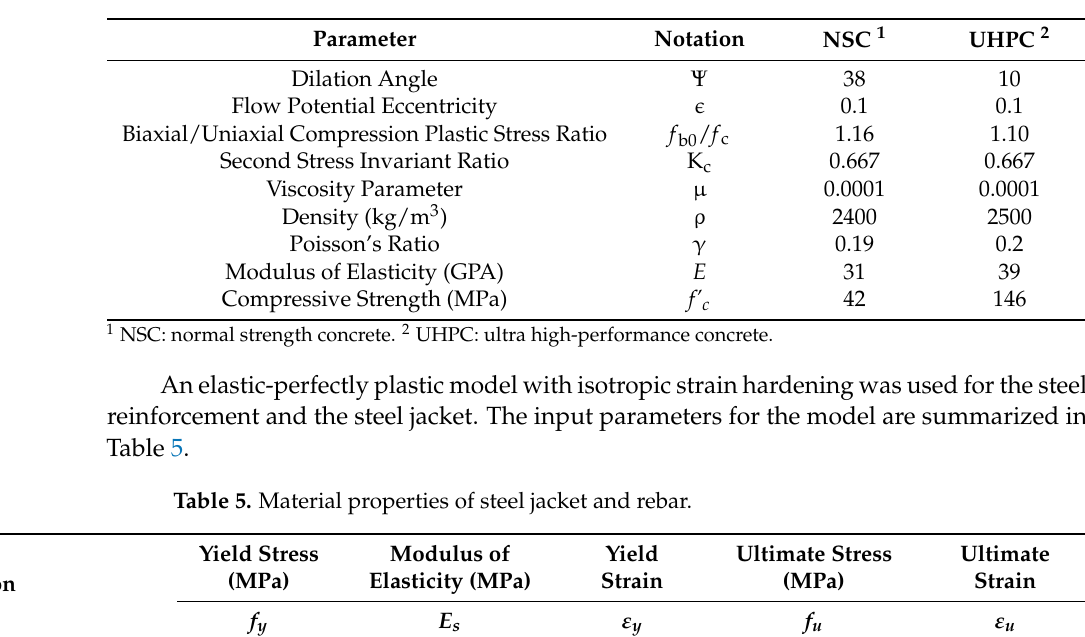
Table 4. Parameters of the CDP model [15,28].